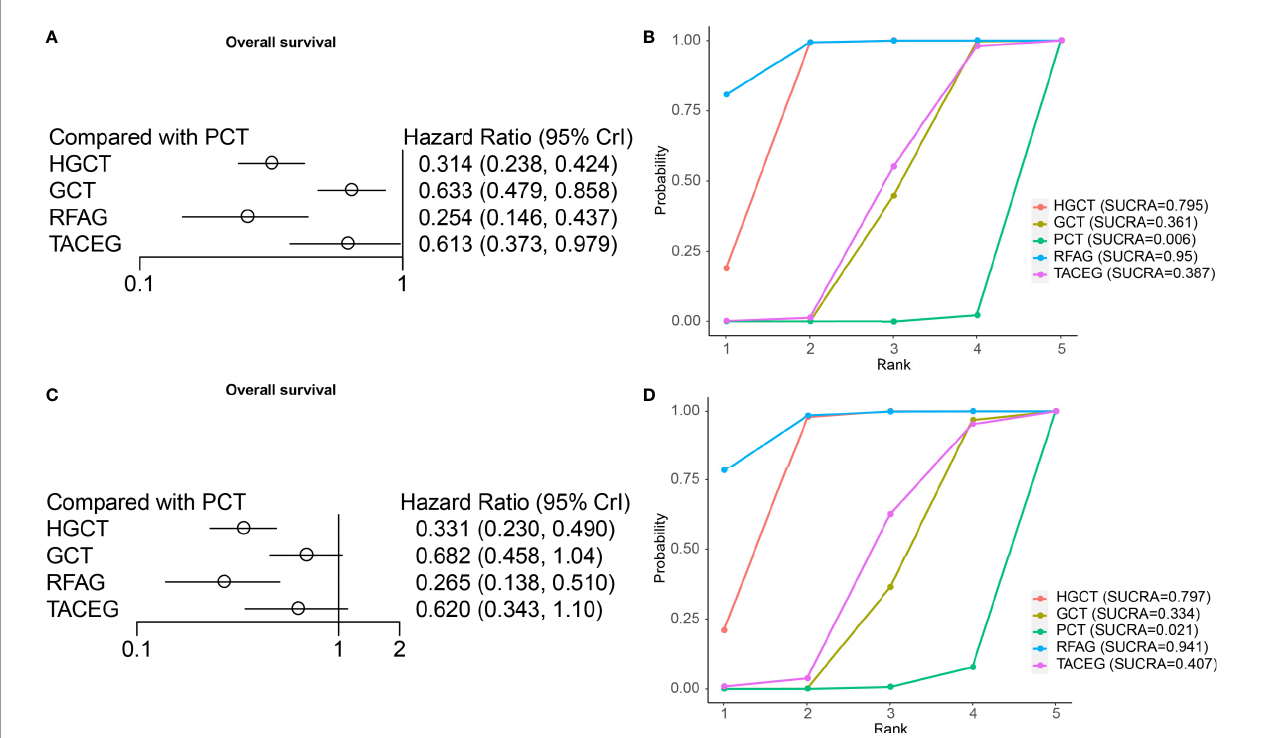
FIGURE 5 | Results from network meta-analyses incorporating direct and indirect comparisons between the eligible interventions (OS). (A) Forest plot of each intervention versus PCT. (B) SUCRA plot of each intervention. (C) Forest plot of each intervention versus PCT in the Asian population. (D) SUCRA plot of each intervention in the Asian